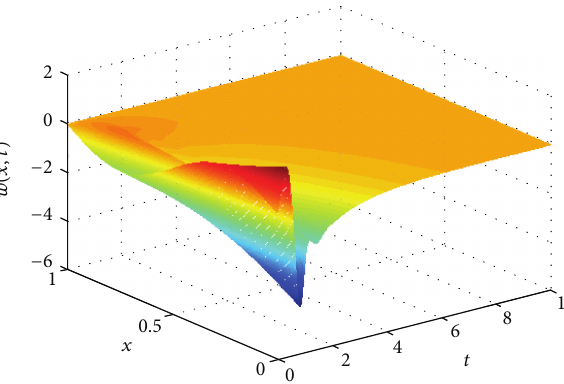
Figure 12: The response of the closed-loop system with control acting on [0.8,1] ( 𝛾 = 7